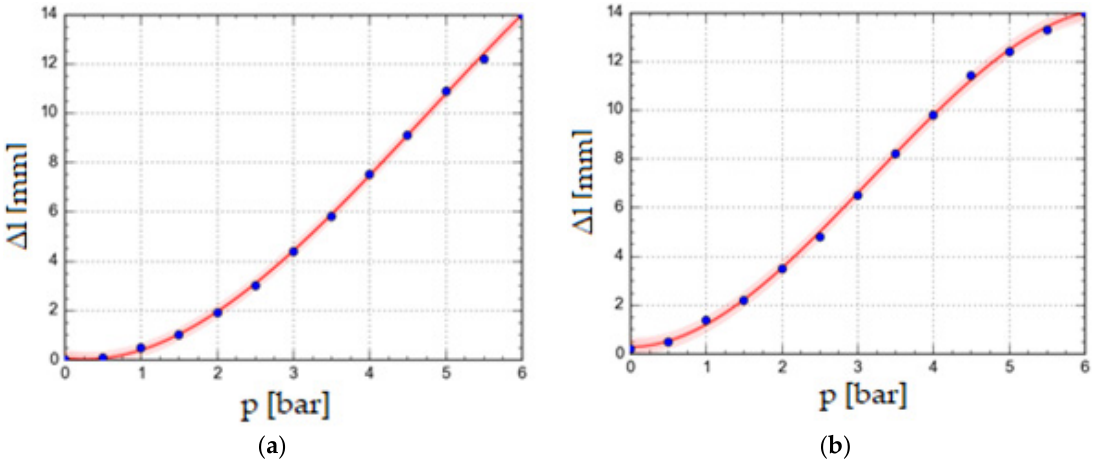
Figure 10. Polynomial regression. ( a ) Inflation; ( b ) deflation.